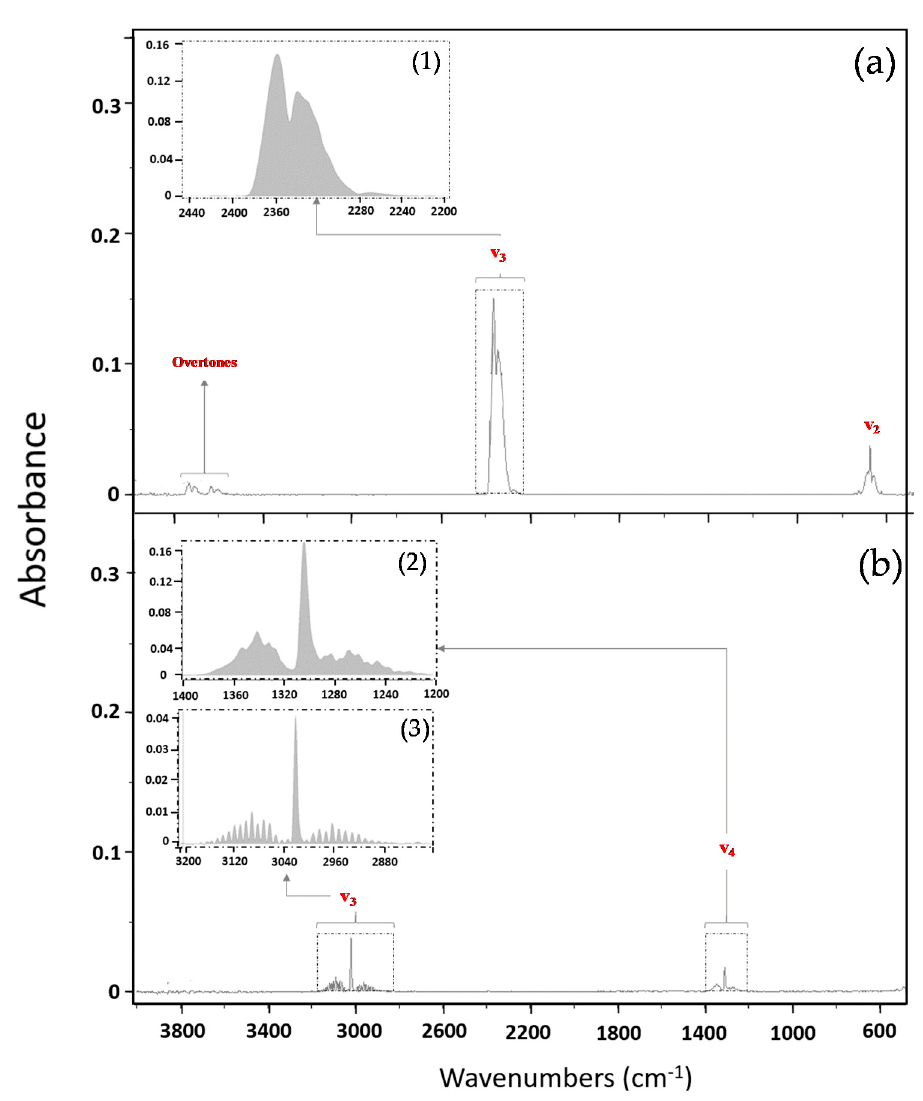
Figure 1. Infrared spectra of 3000 ppm of CO 2 ( a ) and 1800 ppm of CH 4 ( b ). For CO 2 : frequency range for v3 area calculation (1). For CH 4 : frequency range for v4 area calculation (2) and frequency range for v3 area calculation (3).